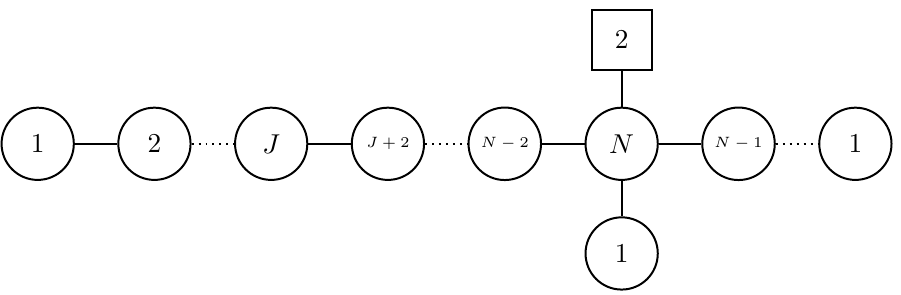
Figure 20 . The common mirror of the quivers in figure 19.